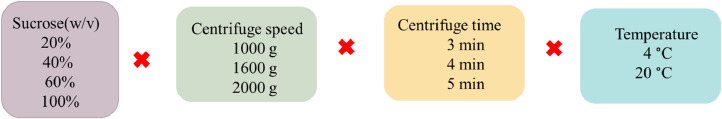
Experimental conditions for density gradient centrifugation tested to select the best combinations of sucrose density, centrifuge speed, time, and temperature for nanoTiO2 separation from algae.